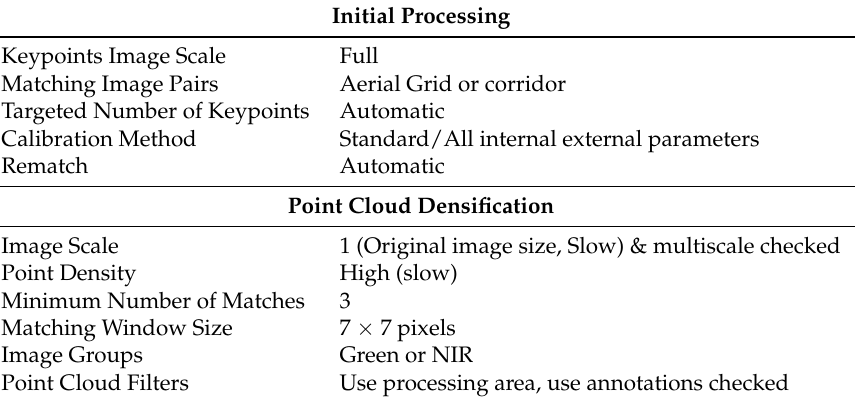
Table 3. Processing parameters used in Pix4D. Parameters not presented were not